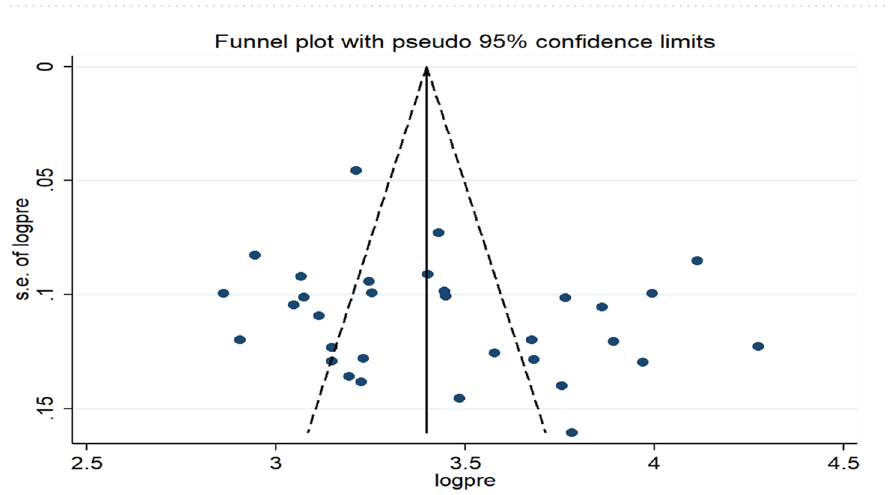
Figure 3. Funnel plot of the pooled prevalence of pre-marital sex among young individuals in Ethiopia,